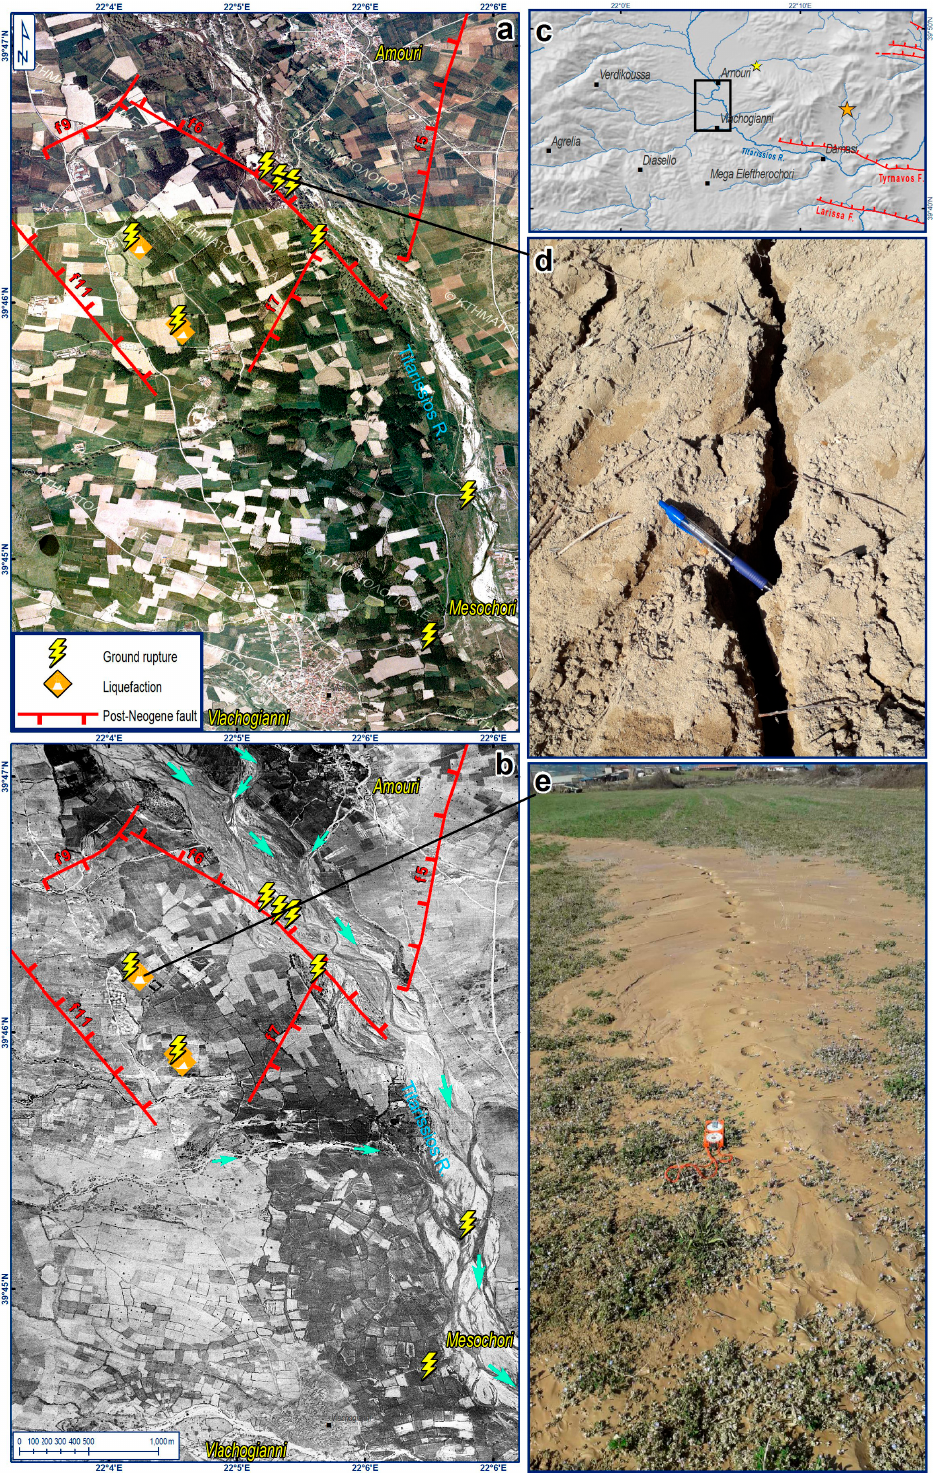
Figure 11. ( a , b ) Photomosaic of the epicentral area where ground deformation phenomena were observed. The ‘post-Neogene’ faults of IGME’s study [50] are also shown. In ( b ), the flow direction of the Elassonitis-Titarissios river and its tributaries is marked with light-blue arrows. Both photomo- saics are obtained from the Hellenic Cadastre, dated in 2016 ( a ) and 1945–1946 ( b ); their location is shown on the hillshade map ( c ). Co-seismic ground ruptures ( d ) also associated with liquefaction ( e ). The general trend of the ruptures is NW-SE. After Galanakis et al.